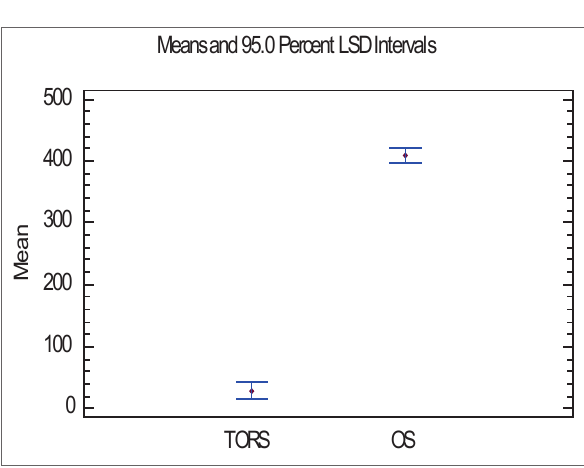
Fig. 1. Blood losses in Tors and os (ml).